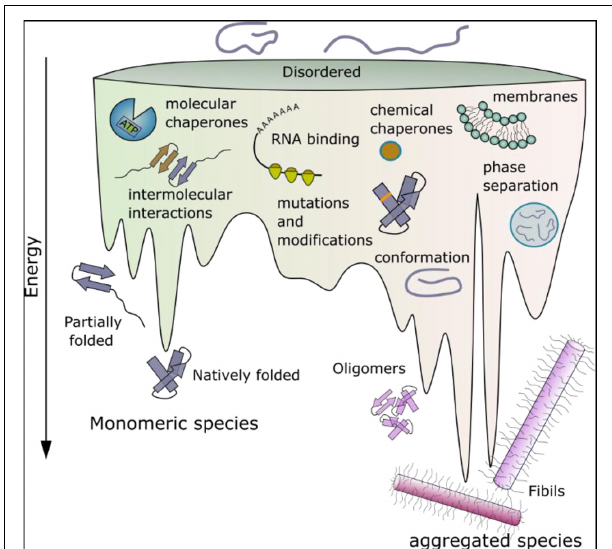
FIGURE 1 | Schematic energy landscape of folding and aggregation of proteins focusing on factors affecting the kinetics of folding and amyloid assembly. The surface shows the conformations that proteins can adopt (monomeric and aggregated species) during folding and aggregation into amyloid. The lowest energy state is the amyloid fibril (Baldwin et al., 2011). Adopting a folded native structure or stabilization of this structure by ligand binding, disfavors amyloid formation, whilst mutations or post-translational modifications that favor inter-molecular interactions and phase separation can destabilize the monomer and tip the balance toward fibril formation. Binding of a protein to a membrane surface can also favor aggregation, by changing the structure of the amyloid precursor and driving inter-molecular interactions. Note that the relative position of each folding- and aggregation-factor within the energy landscape is arbitrary, as these factors can influence folding and aggregation at multiple different points. Their relative position, therefore, does not imply that they act at only one point on the landscape, or interact with a specific folding or aggregation